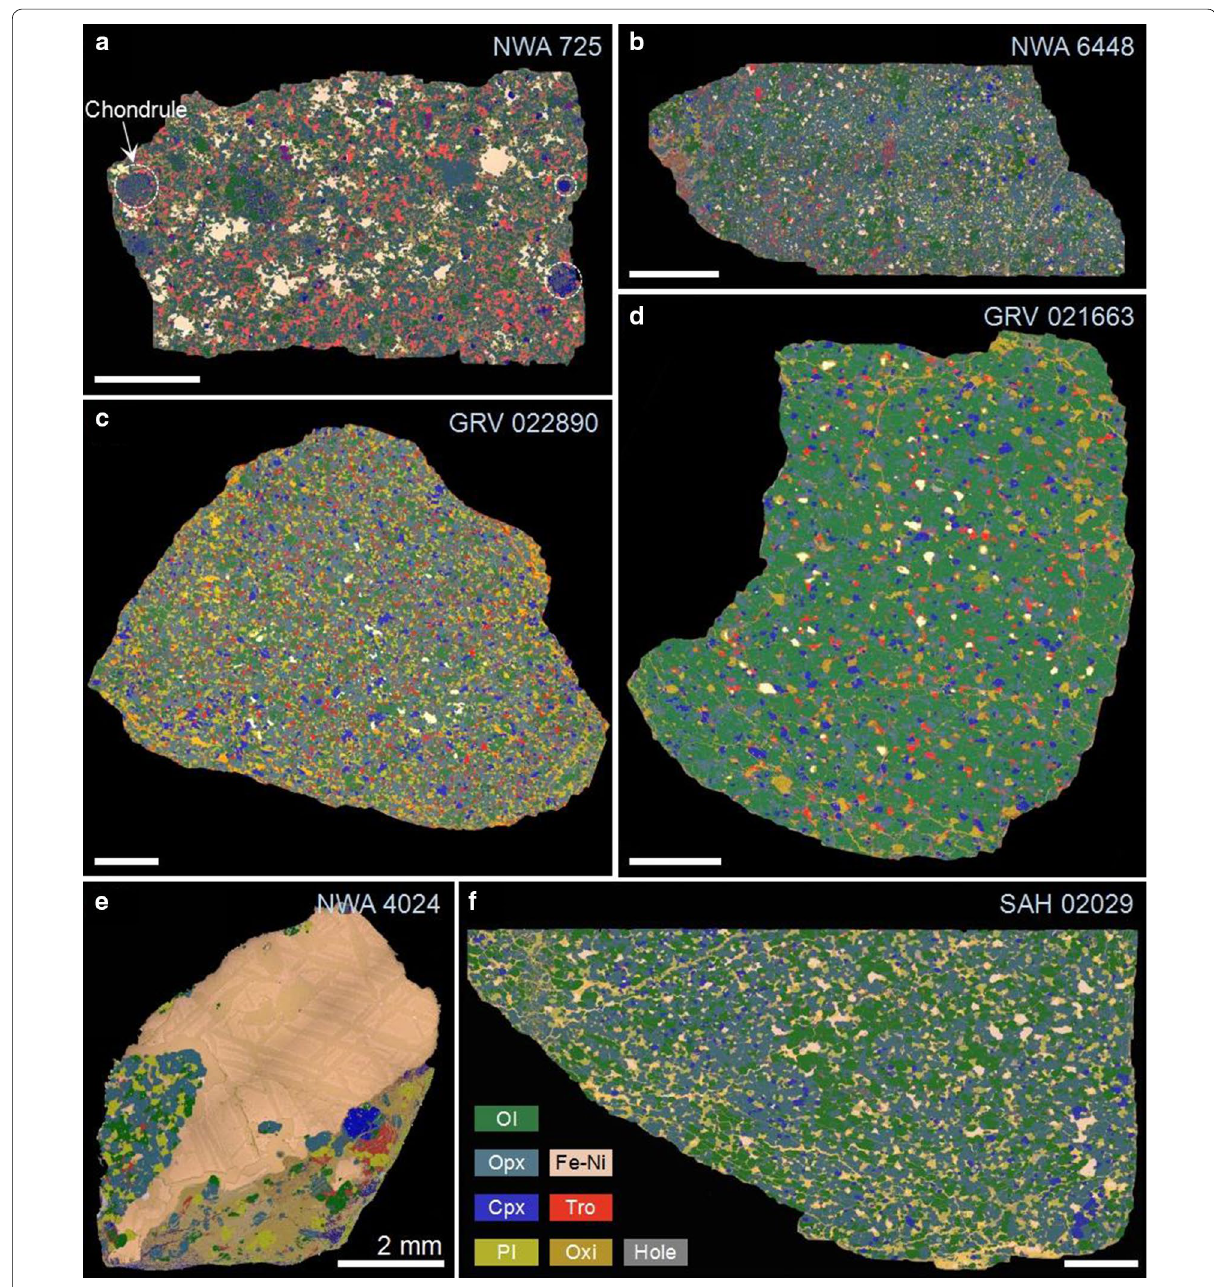
Fig. 1 Mineral distribution maps for the studied winonaites. The meteorites show a wide variety of petrographic textures, including chondritic texture ( a ), fine-grained texture ( b ), recrystallized texture ( c ), olivine-rich texture ( d ), metal-rich texture ( e ), and troilite-poor texture ( f ). Scale bar in all images is 2 mm. The minerals displayed include olivine (Ol), orthopyroxene (Opx), clinopyroxene (Cpx), plagioclase (Pl), FeNi metal (Fe–Ni), troilite (Tro), and Fe–Fe-oxides